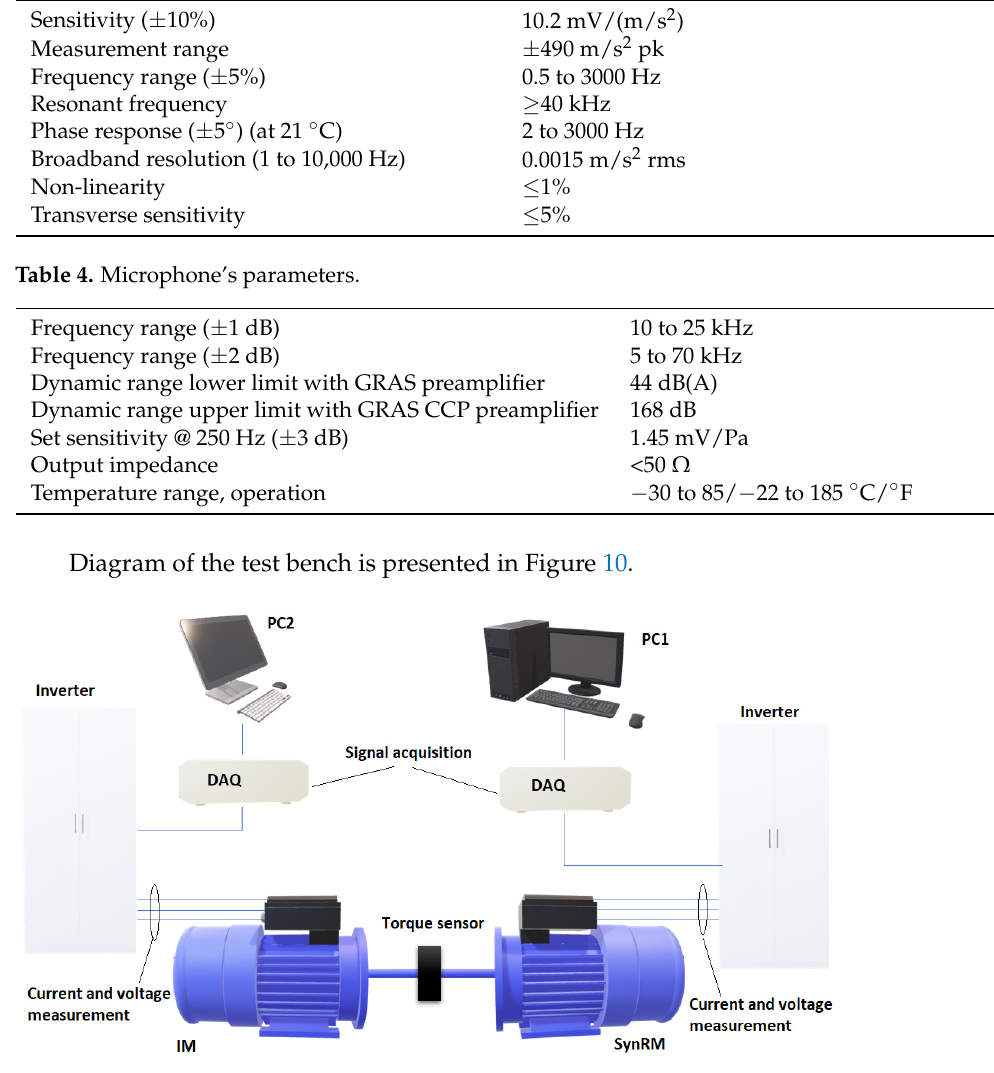
Table 3. Vibration sensor’s parameters.